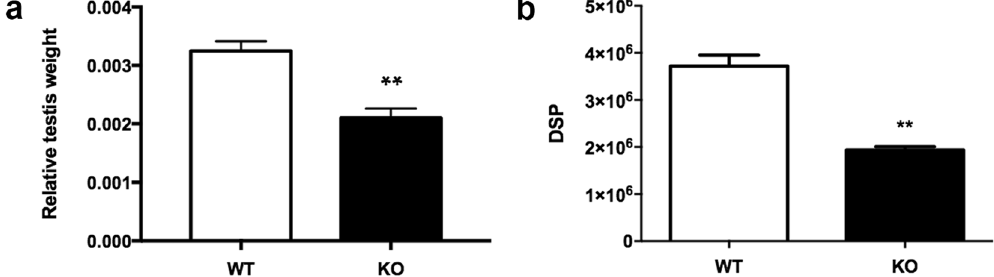
Figure 4. Relative testis weight and daily sperm production of Plag1 wild-type (WT) and knock-out (KO) mice. ( a ) Testis weight relative to body weight of 11–13-week-old males of WT and KO males ( n = 4). ( b ) Daily sperm production (DSP) in KO vs WT males at 11–13 weeks of age ( n = 3). Values shown are means ± SEM. ** P < 0.01 ( t -test).